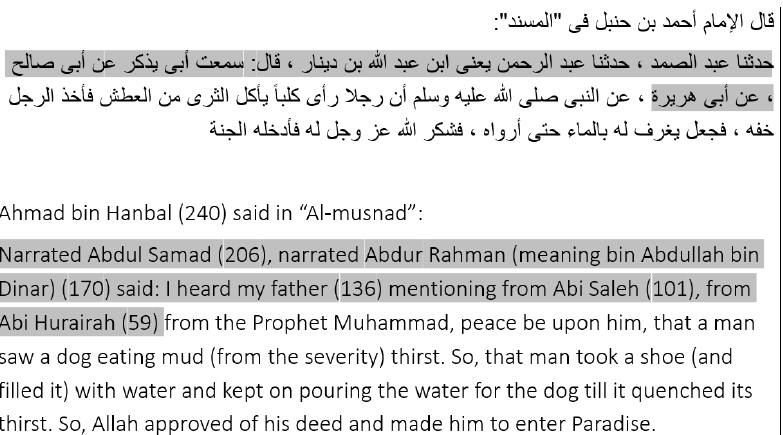
Figure 1. Example hadith from “Musnad Imam Ahmad” by Ahmad bin Hanbal. Top: hadith in Arabic. Bottom: translation of hadith in English. Every narrator’s death date is written in (.) using Hijri